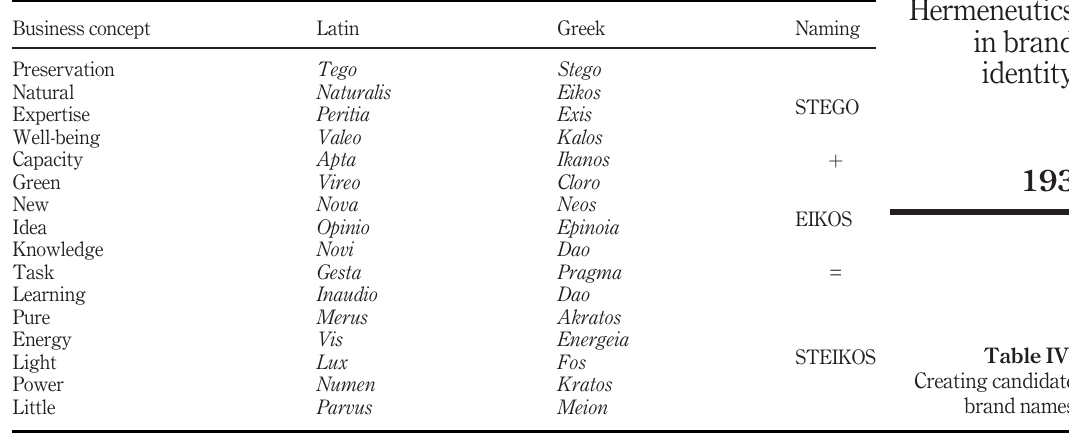
Figure 1. The logo of the